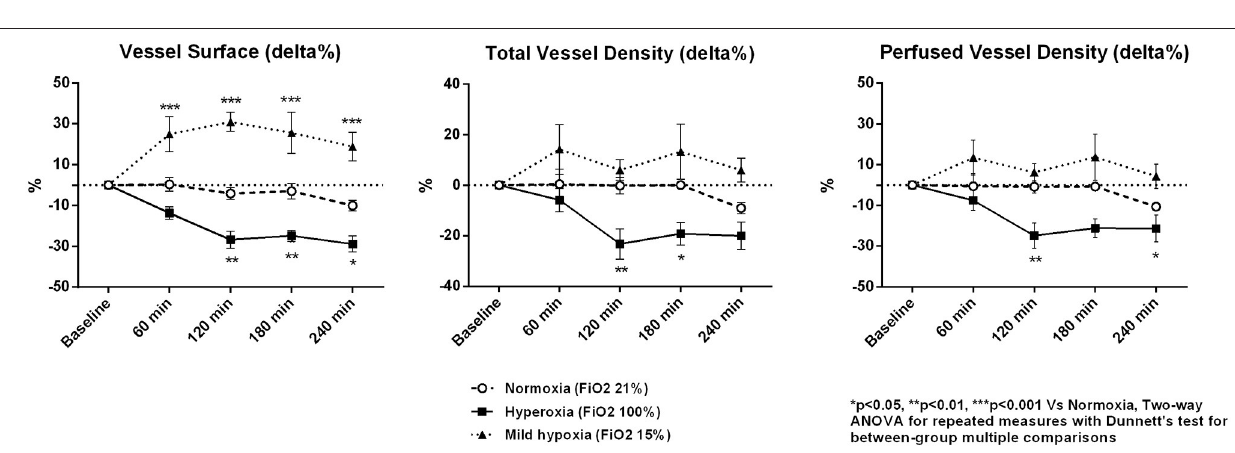
FIGURE 3 | Percentage variations of microcirculatory vessel surface, total vessel density, and perfused vessel density. Data are expressed as mean ± standard